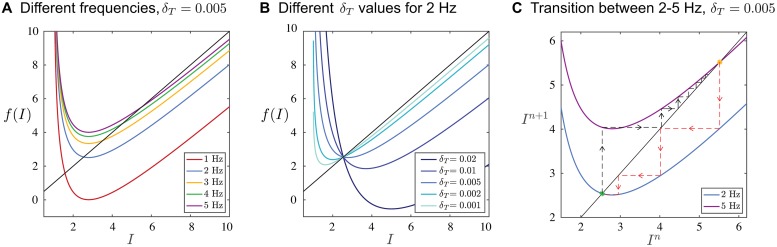
One-dimensional map for period matching illustrated using the LIF model.A. Plots of the map for different frequency stimulus are shown. Each curve crosses the diagonal at exactly one point, corresponding to a fixed point of the map. The slope at this intersection determines stability. As frequency increases, the fixed point moves up and gains stability. B. For the case of 2 Hz, as δT increases, stability is lost. Similar results hold for any stimulus frequency. C. A cobweb diagram of the convergence of a trajectory is shown. Initially, the black trajectory starts at a value corresponding to a 2 Hz oscillation. Then Ibias is shifted to a value corresponding to a 5 Hz oscillation. The trajectory cobwebs over a number of cycles until it converges to the new stimulus frequency. The opposite transition from 5 Hz to 2 Hz is shown in red and occurs over less cycles.